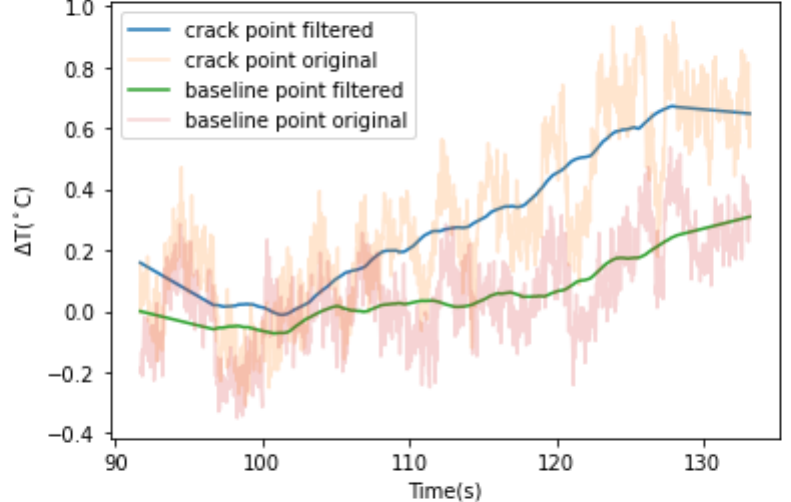
Figure 7. Temperature–time curve of crack point and baseline for clay specimen.